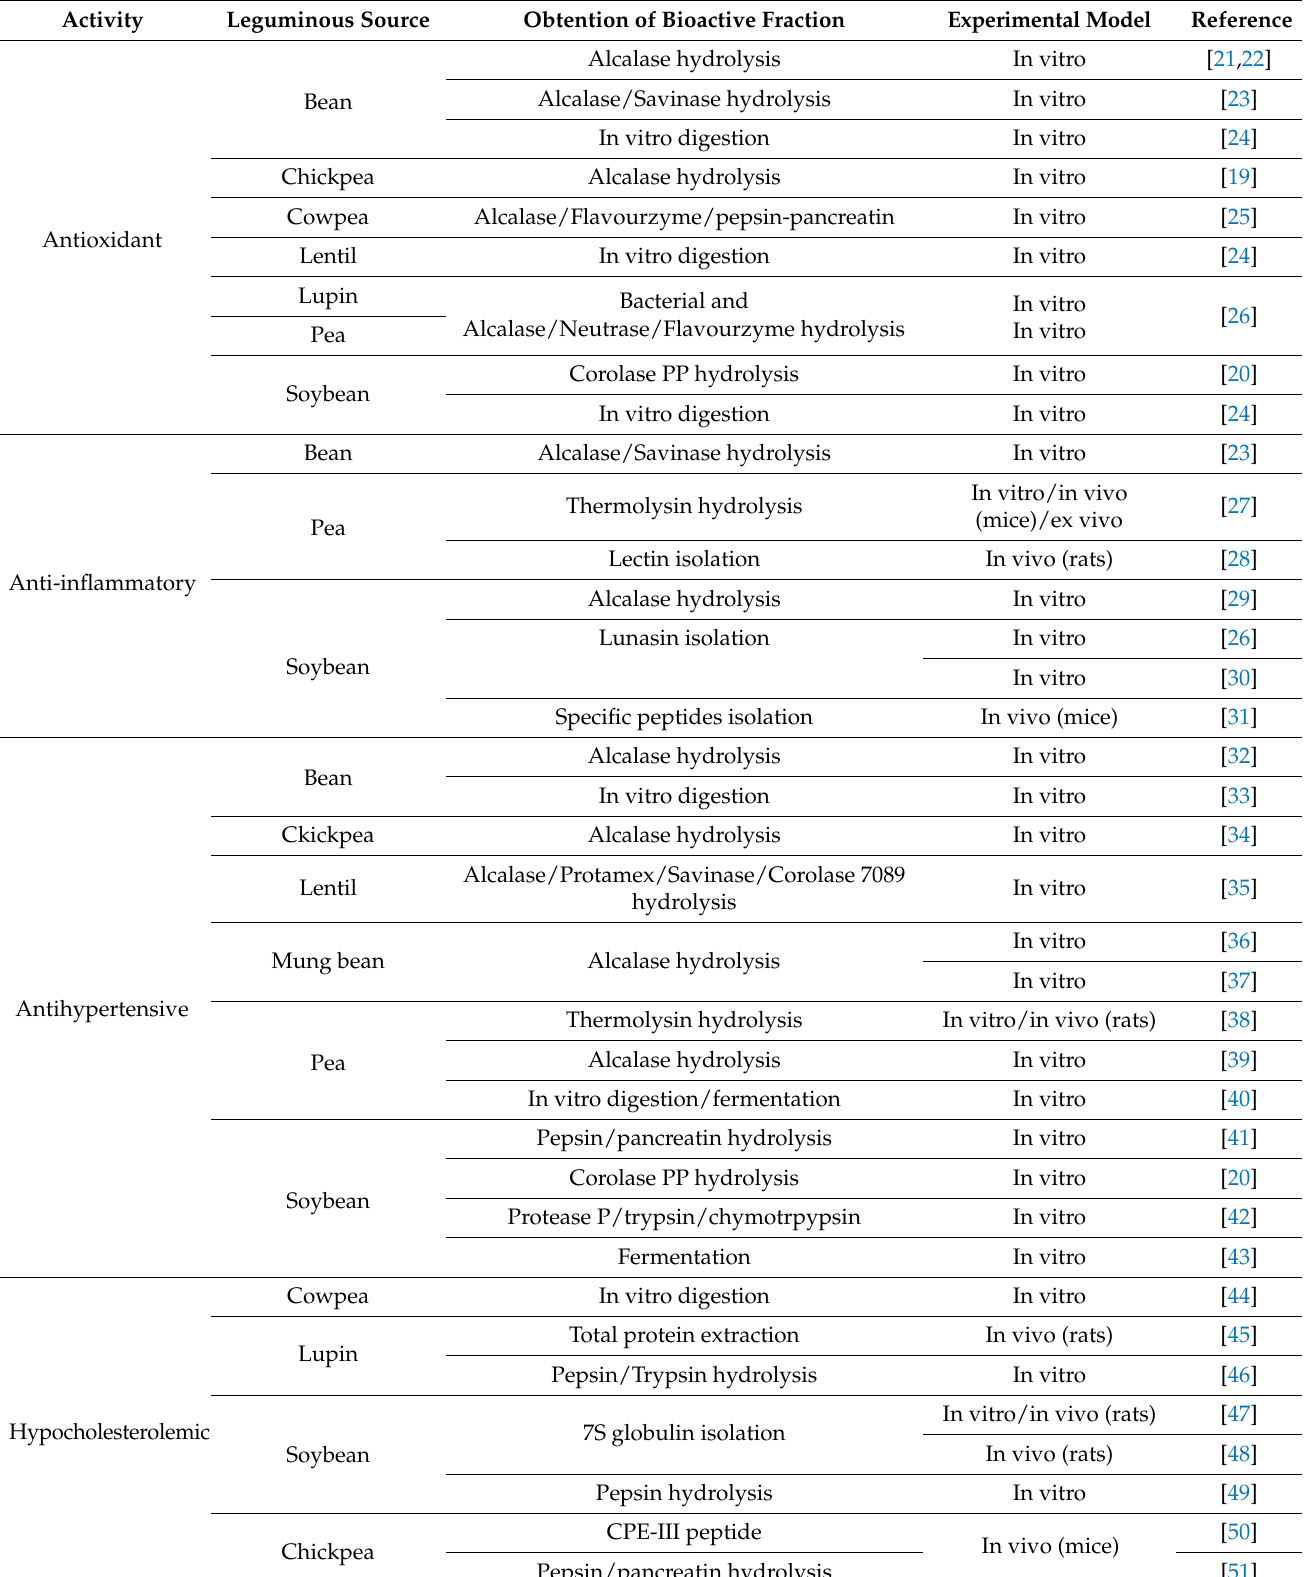
Table 1. Summary of the published works describing the obtention of bioactive protein/peptides fractions from different species of